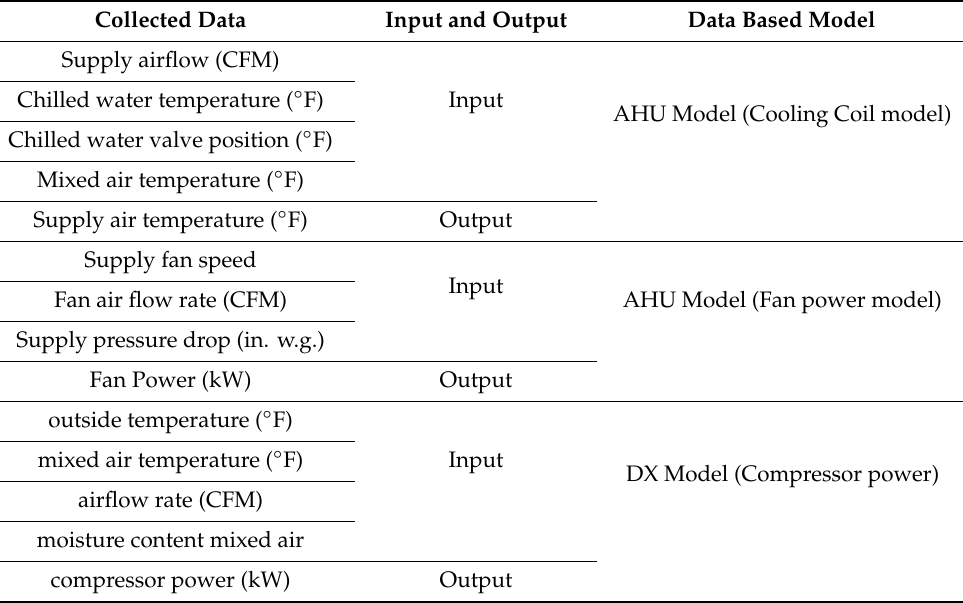
Table 2. The collected data and how they were divided into inputs and outputs for each model. Collected Data